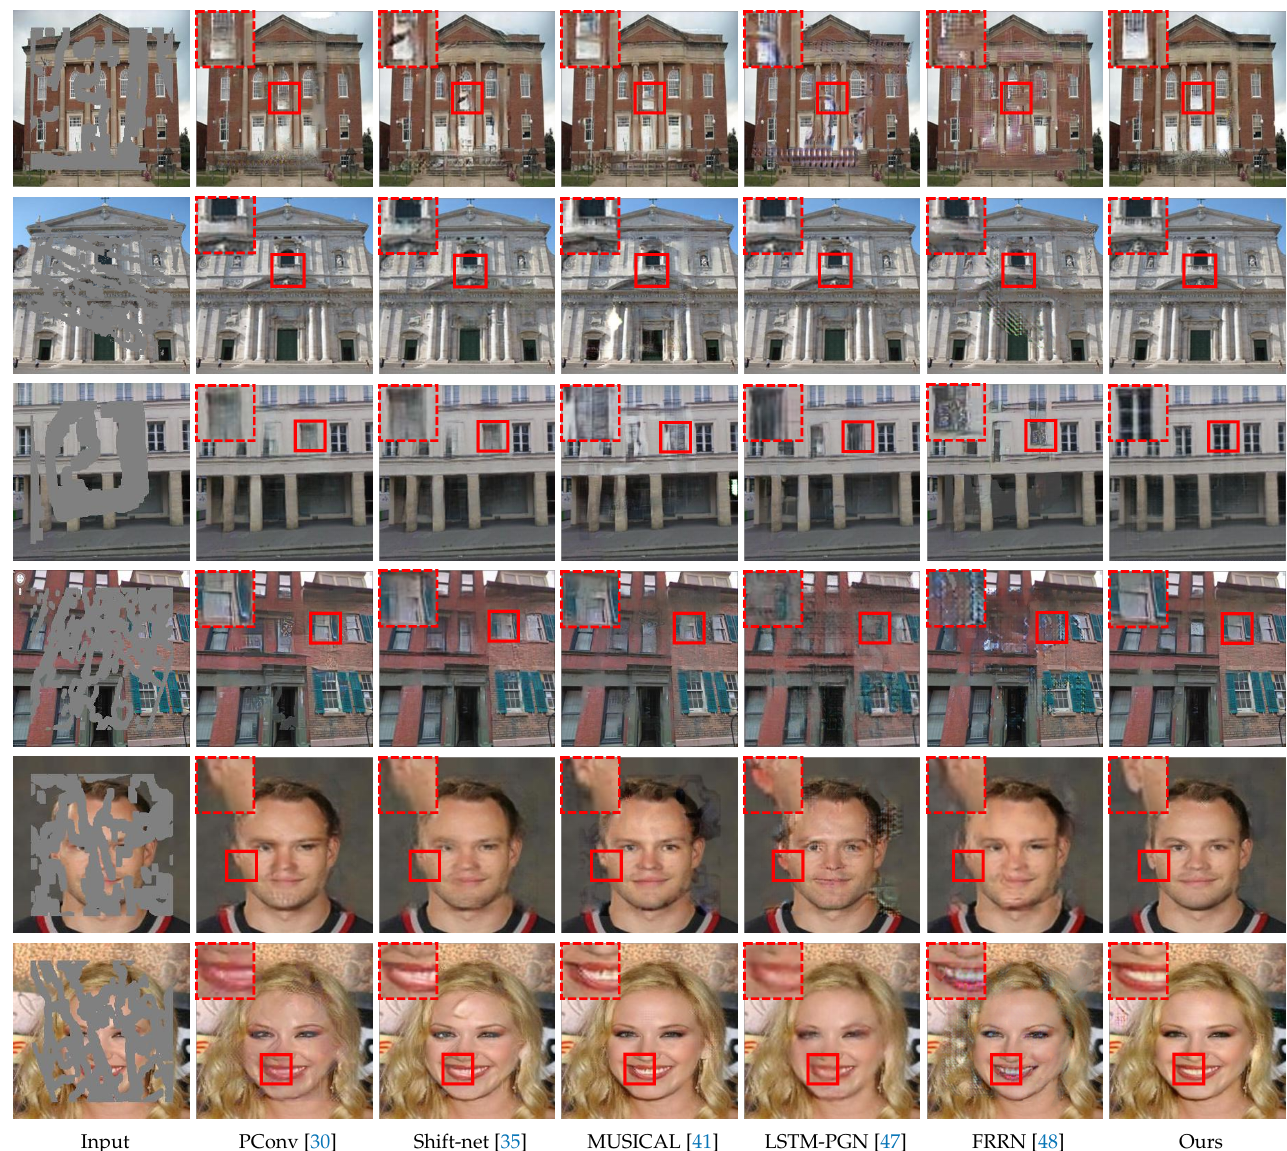
Figure 4. Qualitative results for visual comparisons. From top to bottom, the first two images come from Places2 [57], the middle two from Paris StreetView [58], and the last two from CelebA [59]. All images are free from